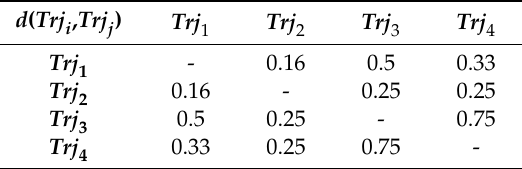
Table 3. Dissimilarity between trajectories.